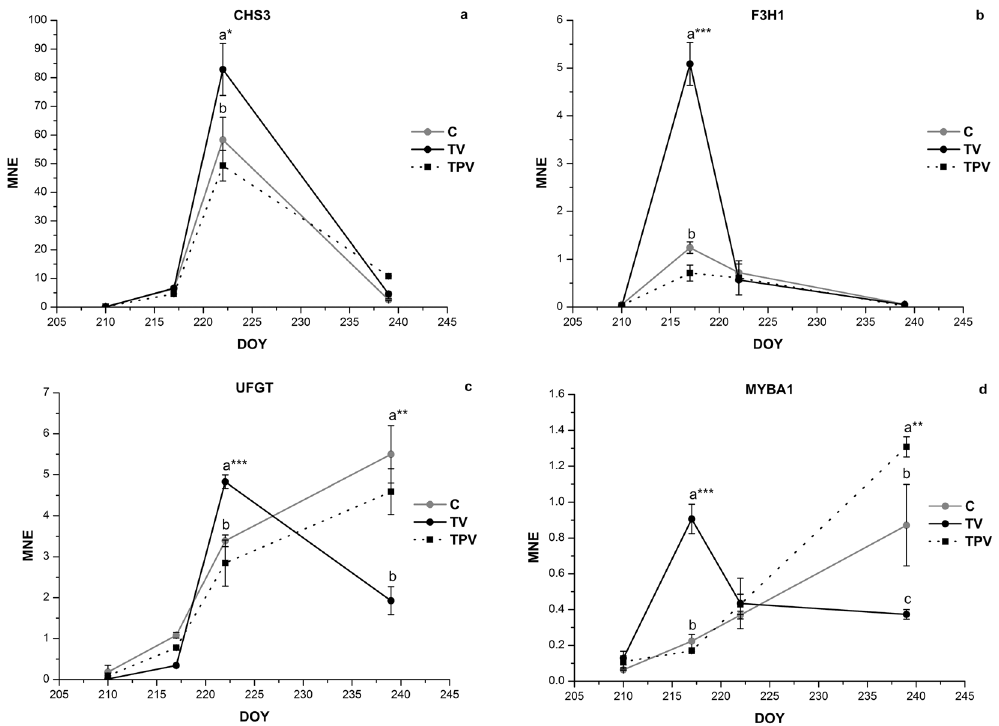
Figure 5. Expression profiles of CHS3 ( a ), F3H1 ( b ), UFGT ( c ) and MYBA1 ( d ) genes in the skin of Corvina grapes treated under low night temperature (TV, TPV) and in the control (C), during the experimental period in 2015. Real time RT-PCR data are reported as mean normalized expression (MNE) values, obtained using Ubiquitin-1 as reference gene. Error bars indicate the mean SE ( n = 3). Means followed by different letters differ significantly, as calculated by Tukey test ( * , ** , *** p ≤ 0.05, 0.01, 0.001